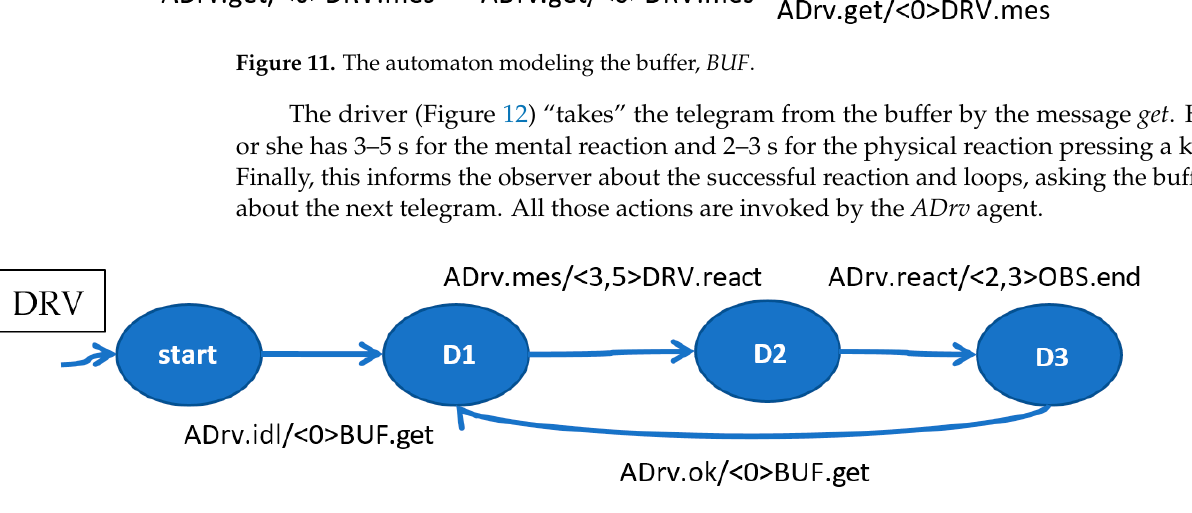
Figure 13. The observer automaton OBS. 7.3. Veri fi cation Process Veri fi cation consists in checking whether the observer can reach the ERR state or if the observer inevitably reaches the SUCCESS state. The Dedan veri fi er automatically fi nds deadlocks and distributed terminations in distributed systems speci fi ed in the IMDS for- malism in a timeless veri fi cation. For timed veri fi cation, the model is exported to the Up- paal [27] veri fi er. The temporal property that must be met for eventually reaching the ob- server termination is A<> (OBS.SUCCESS). This formula, which denotes reaching the given state ( <> ) on every path ( A ) is hidden in Dedan for automated veri fi cation, but, after exporting to Uppaal, it must be supplied manually. In the future, we plan to send both the model and the formulas to Uppaal. Veri fi cation con fi rmed the safety of the model, which means that the SUCCESS state is inevitably reached. Subsequent checking was done by increasing the train’s velocity to a level at which the driver may not be able to con fi rm the telegram. This means that, at this velocity, the telegrams start to overlap in the queue, so, within the assumed maximum reaction time, the driver con fi rms the previous telegram. Checking was carried out for the velocity ranges of 44–60 m/s, 60–80 m/s, and 80–100 m/s. Failure occurs only in the range of 80–100 m/s (above 250 km/h), so the line can be considered safe for ordinary trains, but a tt ention should be paid to the case of high-speed rail. Nowadays, trains run in Poland at 200 km/h, but there are plans to increase the velocity to 250 km/h. For this reason, such a line should be reconstructed. 7.4. Modi fi ed Example We also checked whether the driver could con fi rm an additional telegram coming from other line elements than the balises. This required the following modi fi cations: •